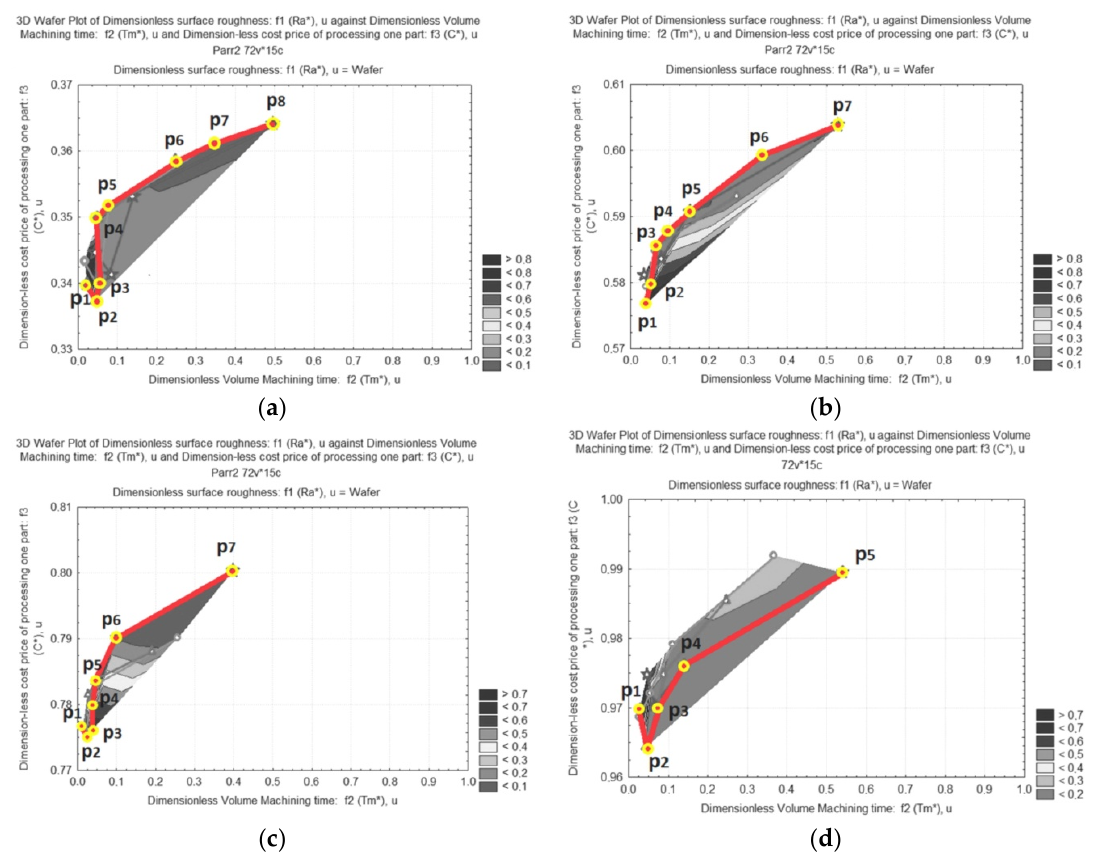
Figure 12. The Pareto frontier and eight reference points in the case of: ( a ) obtaining an AA6061